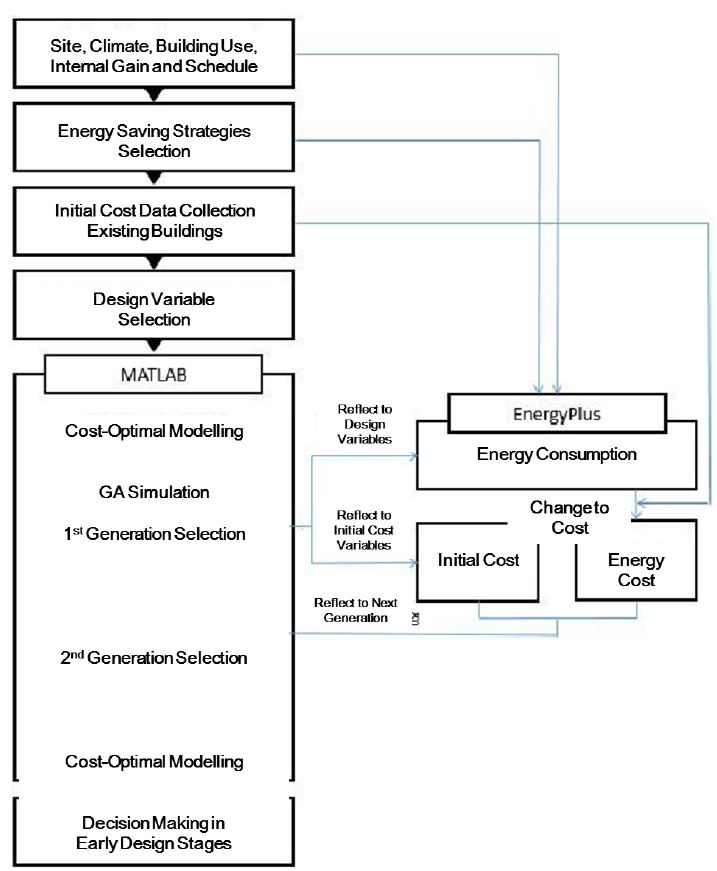
Figure 7. Process for Cost-Optimal Modelling of Energy Saving Buildings.